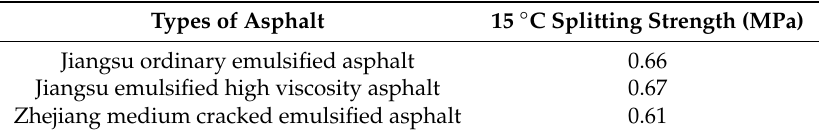
Table 8. Cleavage strength of samples with di ff erent EACRMs.